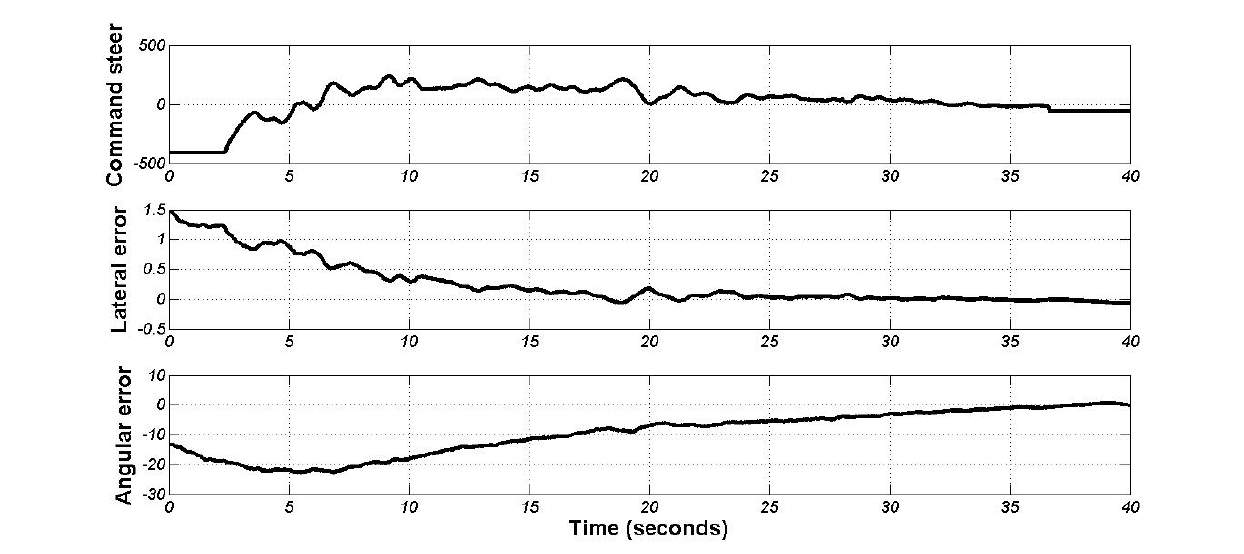
Figure 12. Lateral command and variables of the control in the last